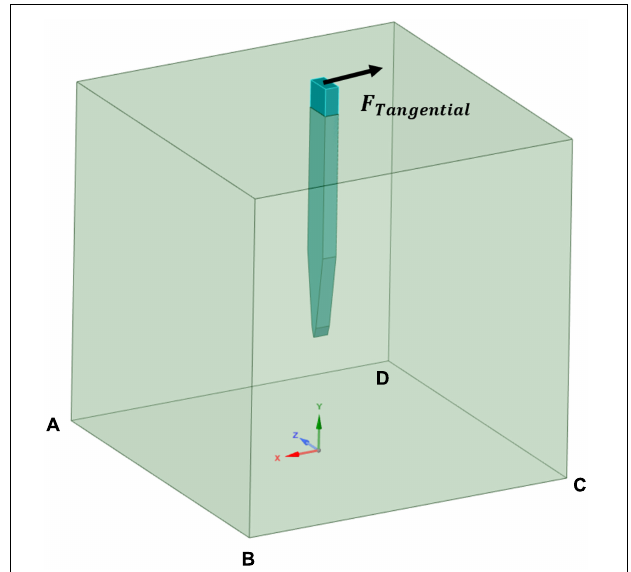
FIGURE 4 | Simulation cases boundary conditions. A tangential load was applied at the probe’s upper surface and fixed supports defined at the edges of the bottom surface of the tissue model (AB, BC, CD, and DA).